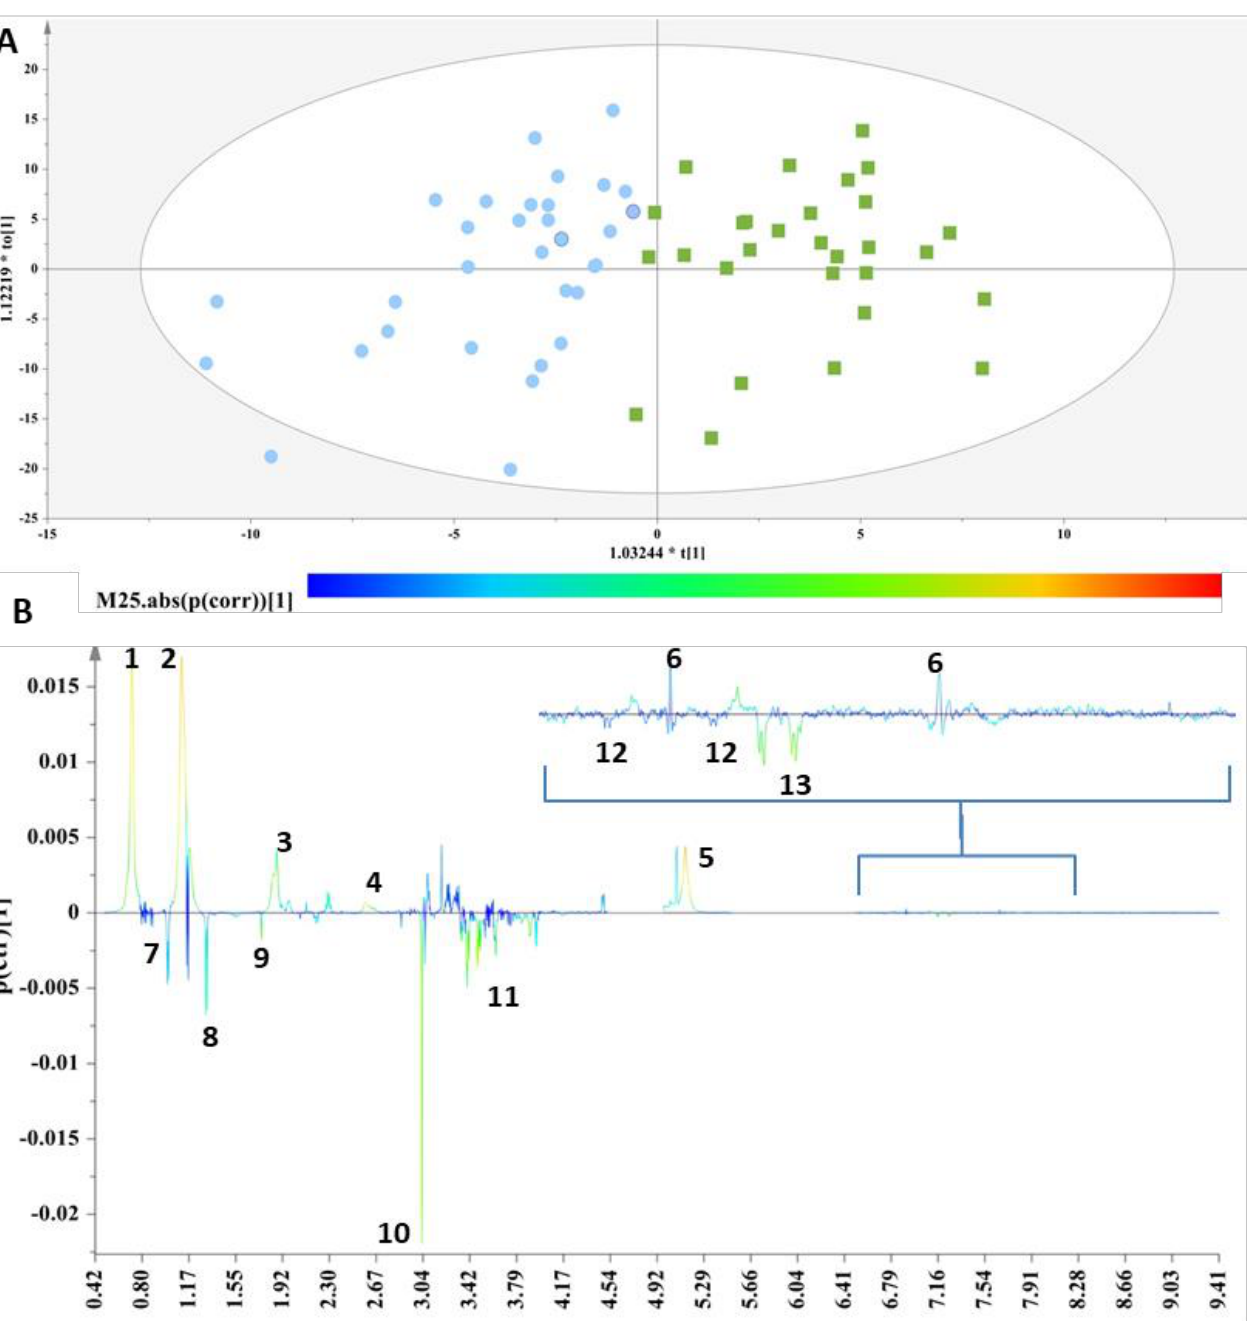
Figure 1. ( A ) OPLS-DA model; A = 1 + 1, N = 62; R 2 X(cum)= 0.61, R 2 Y(cum) = 0.62 and Q 2 (cum) = 0.45. Green squares = samples with thyroid disorder and blue circles= control samples. ( B ) S-line plot (1: cholesterol-VLDL, 2:LDL2/VLDL2, 3: n-acetylated glycoproteins, 4: methionine (2-amino-4- (methylsulfanyl)butanoic acid), 5: unsaturated lipid, 6: 1-methylhistidine, 7: valine (2-amino-3- methylbutanoic acid), 8: alanine (2-aminopropanoic acid), 9: acetic acid, 10: methanol, 11: glycerol, 12: tyrosine(2-amino-3-(4-hydroxyphenyl)propanoic acid) and 13: L-phenylalanine (2-amino-3-phe- nylpropanoic acid).